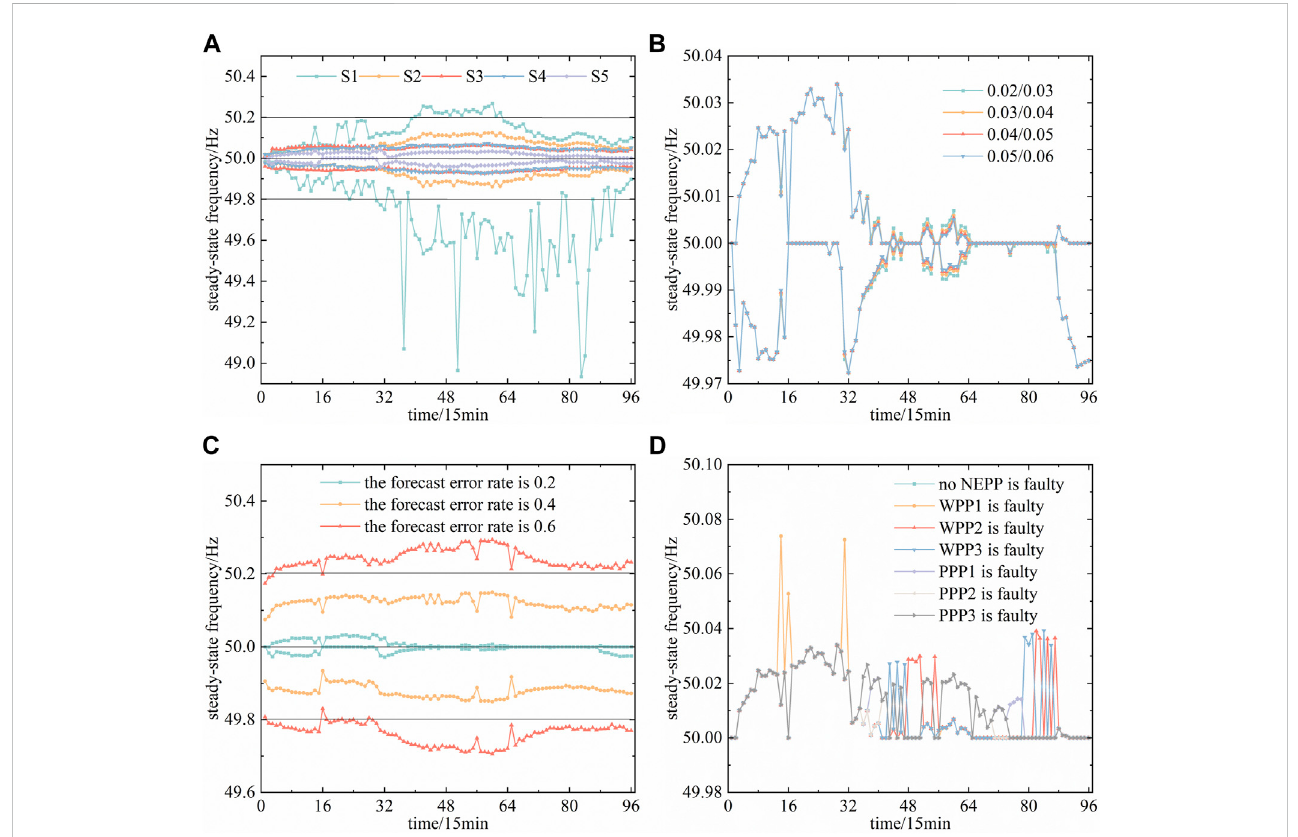
FIGURE 10 Steady-state frequency deviation of the system: (A) steady-state frequency deviation of the power system in the fi ve scheduling strategies, (B) steady- state frequency deviation in S5 when changing difference coef fi cients of NEPPs, (C) steady-state frequency deviation in S5 when the error of new energy forecast is large, and (D) steady-state frequency deviation in S5 when the NEPP is faulty.